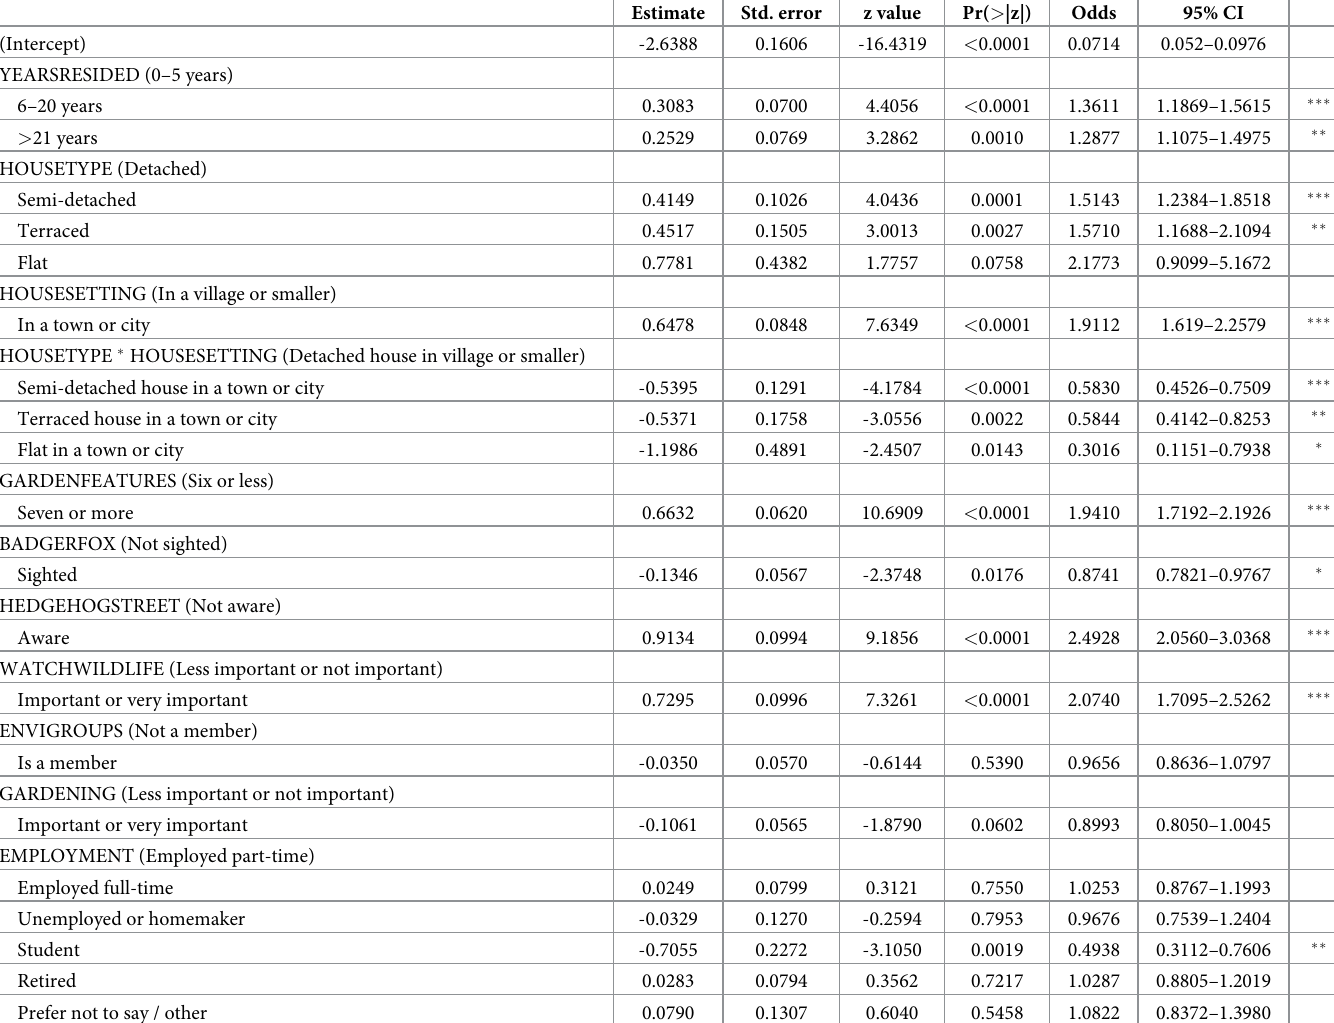
Table 4. Summary of the binary logistic regression analysis examining the effects of garden and householder-related variables on the respondent’s decision to make a hedgehog highway (HIGHWAY) (N = 5986).